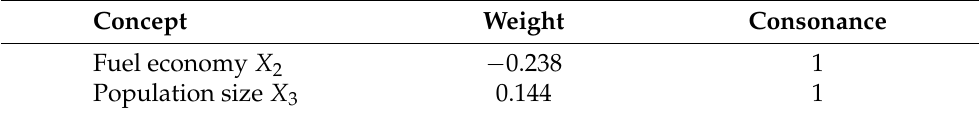
Table 2. Maximum solution of the inverse problem in the transportation system.